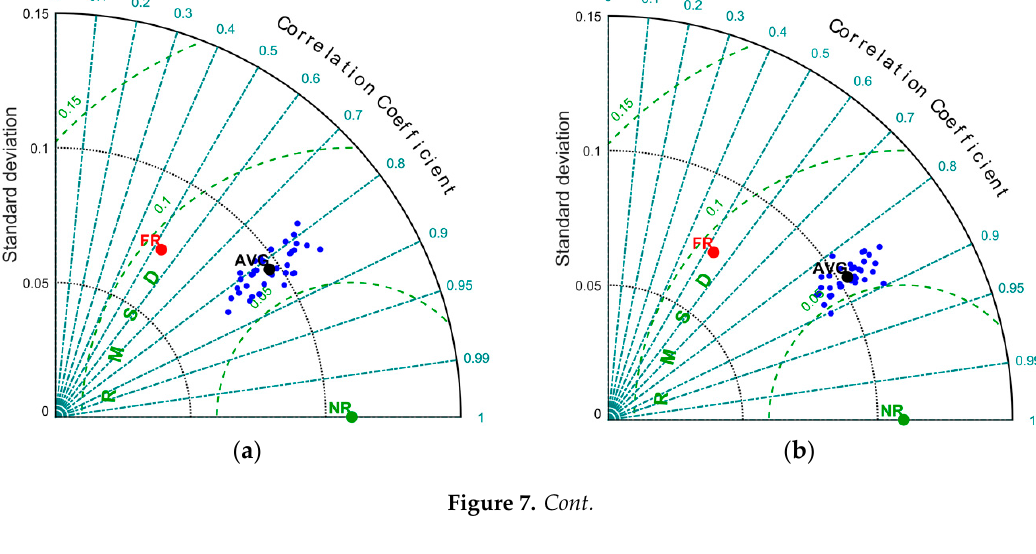
( d ) Figure 7. Representation of the ensemble of the analyses obtained from datasets of velocity measurements from, respectively, 40 ( a ), 60 ( b ), 80 ( c ), and 150 ( d ) observation points randomly positioned (blue points), Free Run (red point), and Nature Run (green point) in the first assimilation window. ( b ) Figure 8. Representation of the average point representing a different ensemble of ( a ) the analyses obtained from datasets of velocity measures characterized by a different number of observation points randomly positioned: 20, 40, 60, 80, 150, and 200; ( b ) the subsequent forecast.